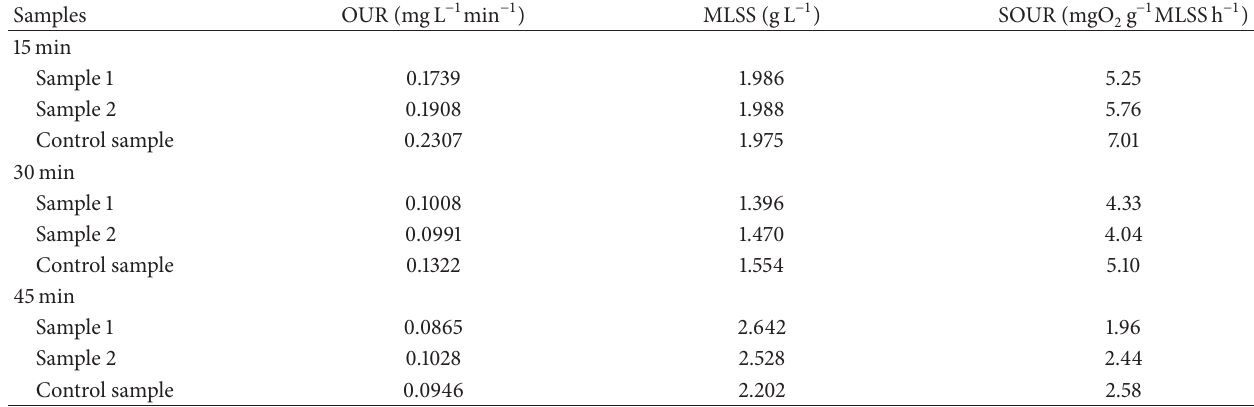
Table 3: SOUR of effluent at electrolysis time of 15min, 30 min, and 45